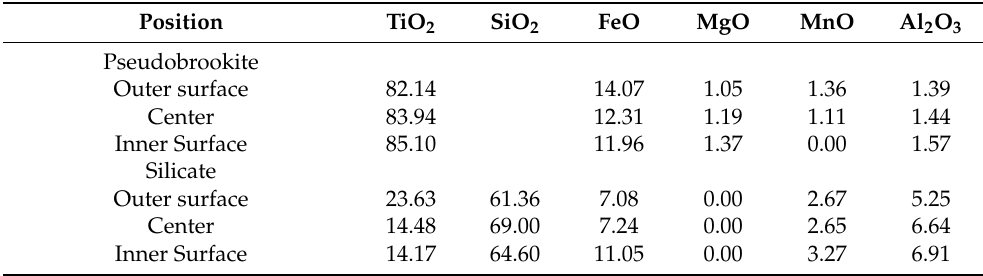
Table 5. Average composition of different regions in the slag sample 10 obtained with EDS.